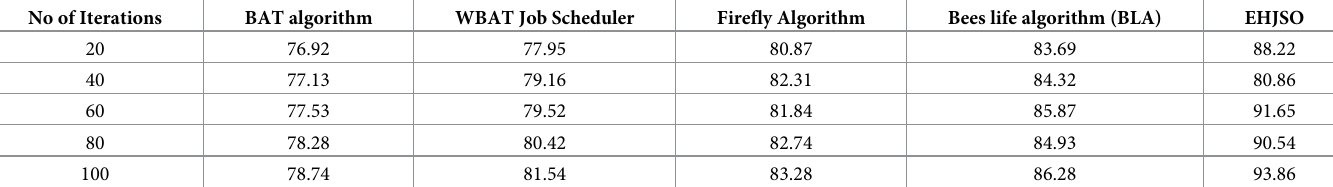
Table 5. Performance based on Iterations analysis for EHJSO method with existing system.